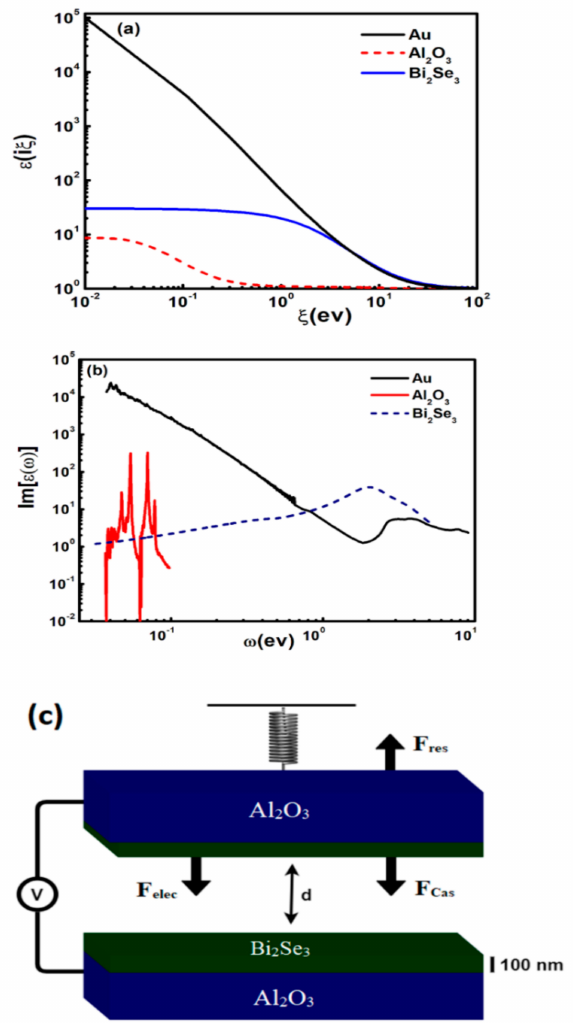
Figure 1. ( a ) Dielectric functions at imaginary frequency for Au, Al 2 O 3 , and Bi 2 Se 3 . ( b ) Imaginary part of the frequency-dependent dielectric functions for Au, Al 2 O 3 , and Bi 2 Se 3 obtained by ellipsometry. ( c ) Schematic of the MEMS made of Al 2 O 3 covered with an Au or Bi 2 Se 3